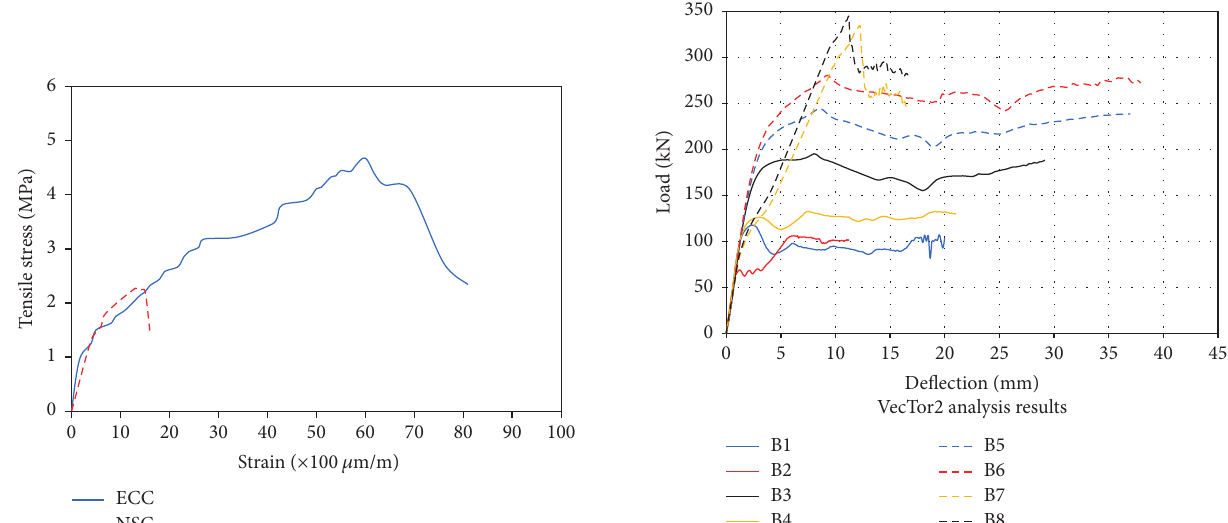
Figure 16: Load-deflection relationships for R-SC-ECC beams.